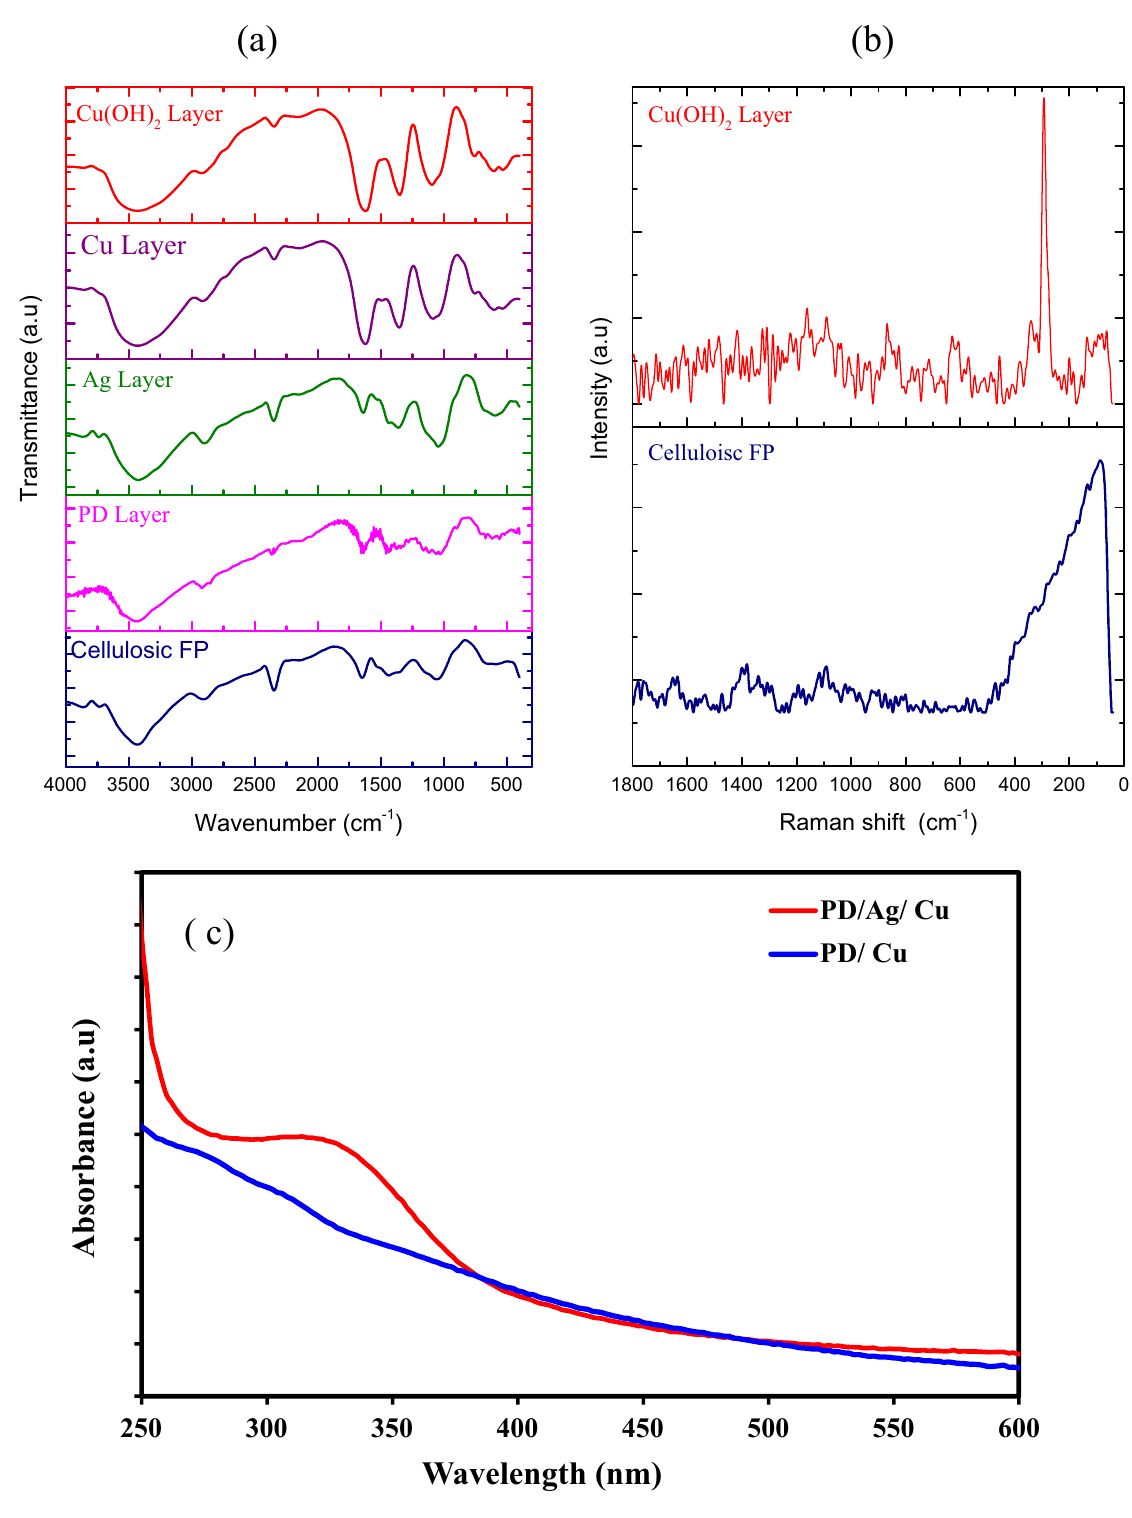
Figure 1. FTIR ( a ) Raman ( b ) spectra of cellulosic filter paper modified with different layers , ( c ) UV–Vis of PD/Ag/Cu and